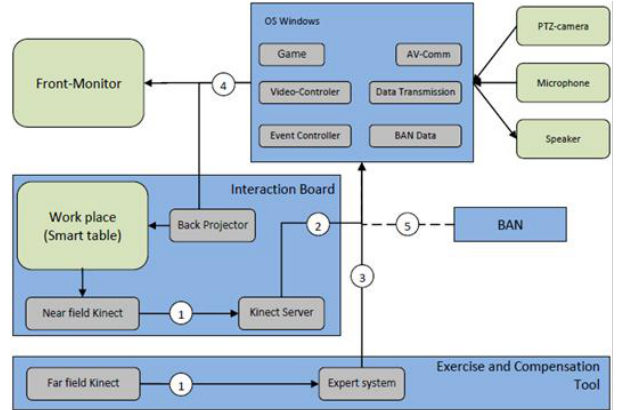
Figure 5. Integration of the overall “home” system A sub-unit assembly diagram of the “Patients home training place” is depicted in Figure 5. The blue and grey rectangles designate respective elements, while green ones are the user interfaces. The PTZ-camera features pan-tilt-zoom. Arrows show the data flow. The